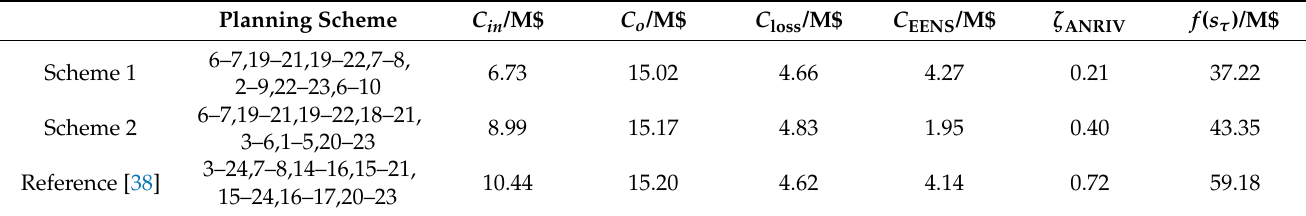
Table 1. IEEE 24-bus reliability test system planning scheme comparison.